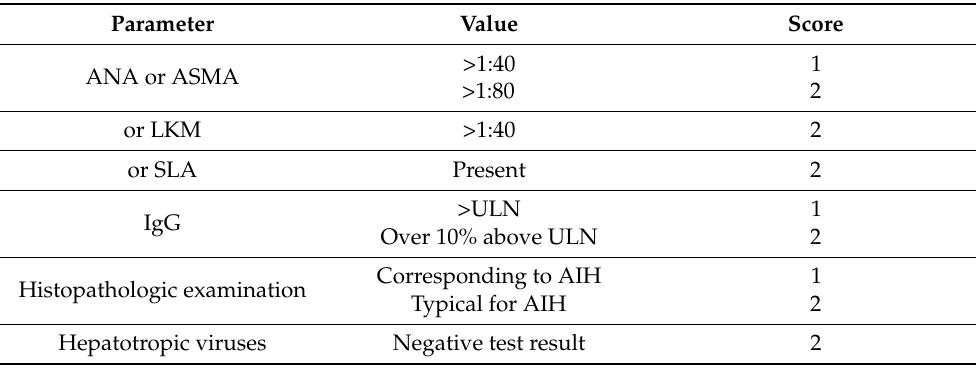
Table 2. Simplified criteria for AIH diagnostics of the International Autoimmune Hepatitis Group (IAHG)